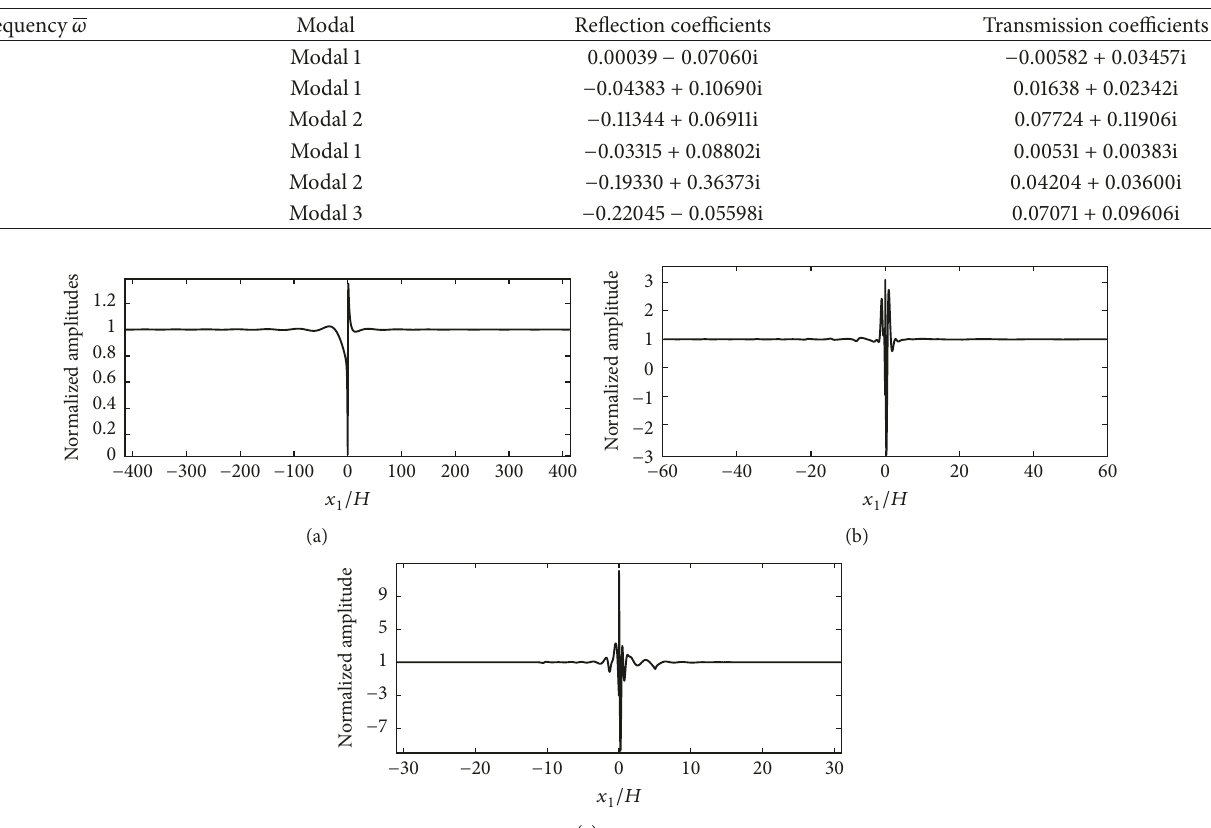
Table 2: The transmission and reflection coefficients with truncated locations at 𝑥 = ±60𝜆 𝐿 /𝐻 , ℎ = 0.2 ( 𝜆 𝐿 being the Love wavelength for the lowest mode), for a circle arc defect at the bonding interface.